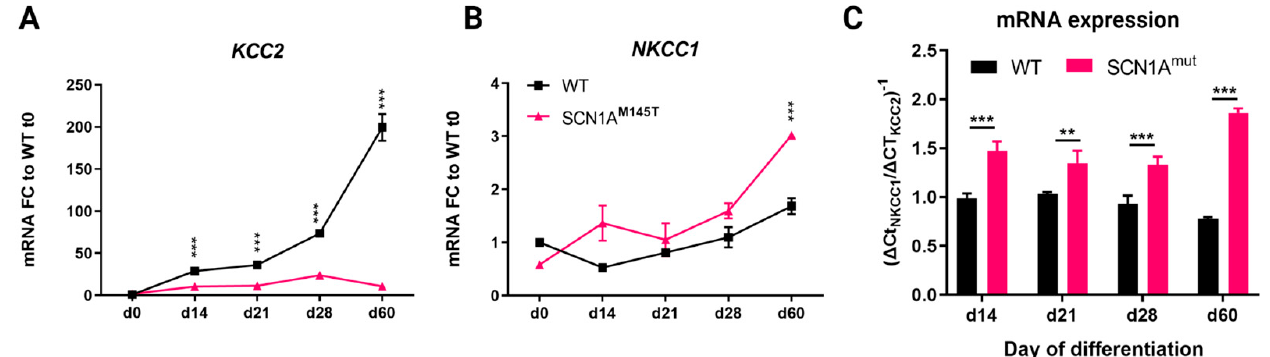
Figure 5. Expression of chloride co-transporters in idNs. ( A , B ) qRT-PCR analysis of chloride co- transporters KCC2 and NKCC1 in neurons from WT and SCN1A M145T tested at day of differentia- tion 0 (NSCs), d14, d21, d28 and d60. ( C ) NKCC1 / KCC2 mRNA ratio in idNs at different days of